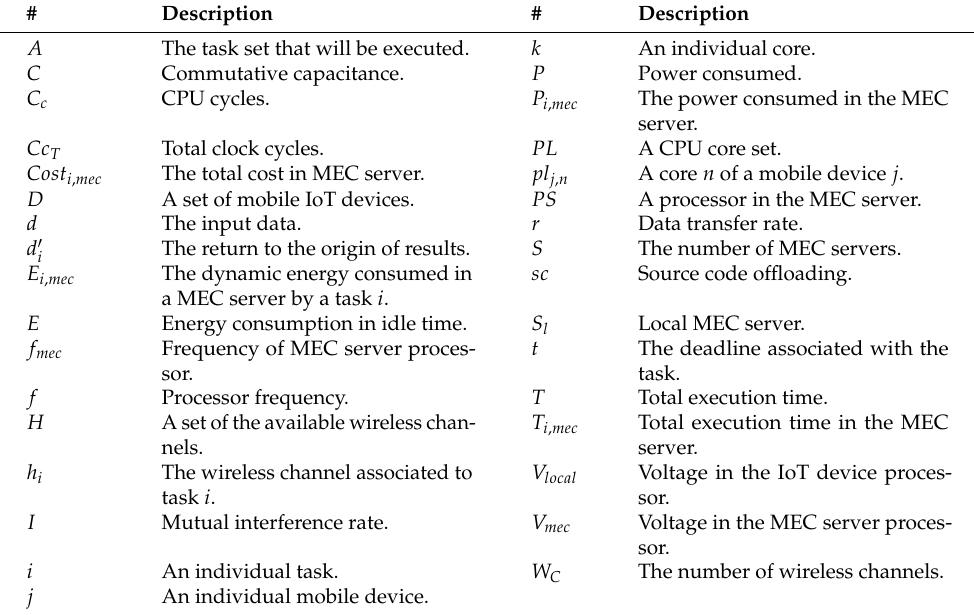
Table 2. Notation adopted for the model